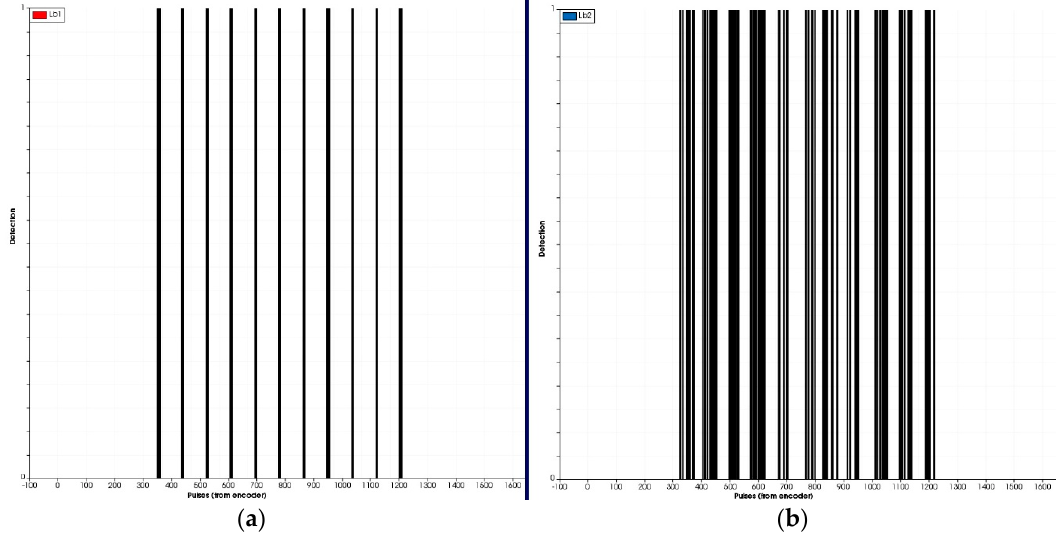
Figure 5. ( a ) Stem detection of the 11 artificial plants through the lower pair of light-beam sensors. ( b ) Detection of the aerial part (leaves and branches) of the 11 artificial plants through the centre pair of light-beam sensors.